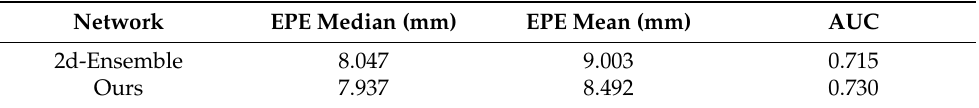
Figure 5. Comparative experiment of the effectiveness of newly added five 3D finger pose constraints. Table 2. Error analysis of newly added five 3D finger pose constraints